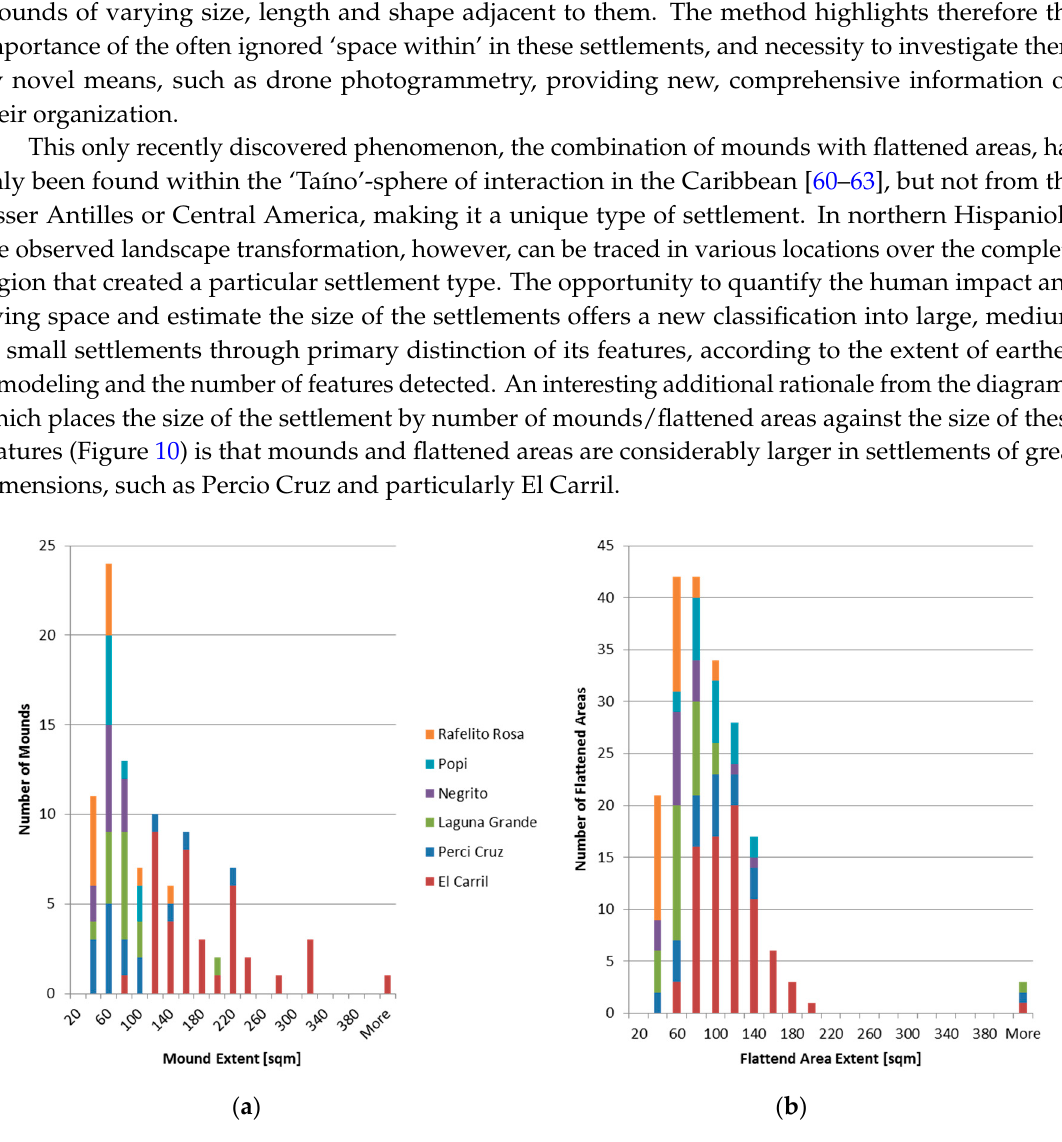
Figure 10. Comparison of the number of the ( a ) mounds and ( b ) flattened areas of the Indigenous settlement sites vs. their size, indicate mounds and flattened areas are of greater dimension in larger settlements.